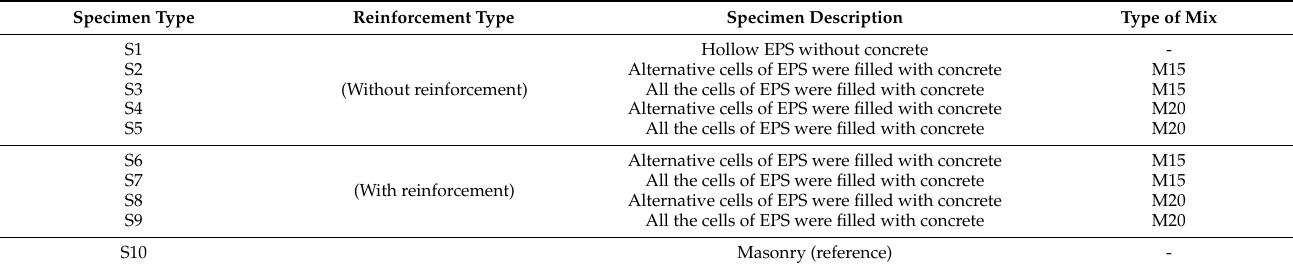
Figure 2. Structure of the EPS shell. Table 4. Details of the ICF